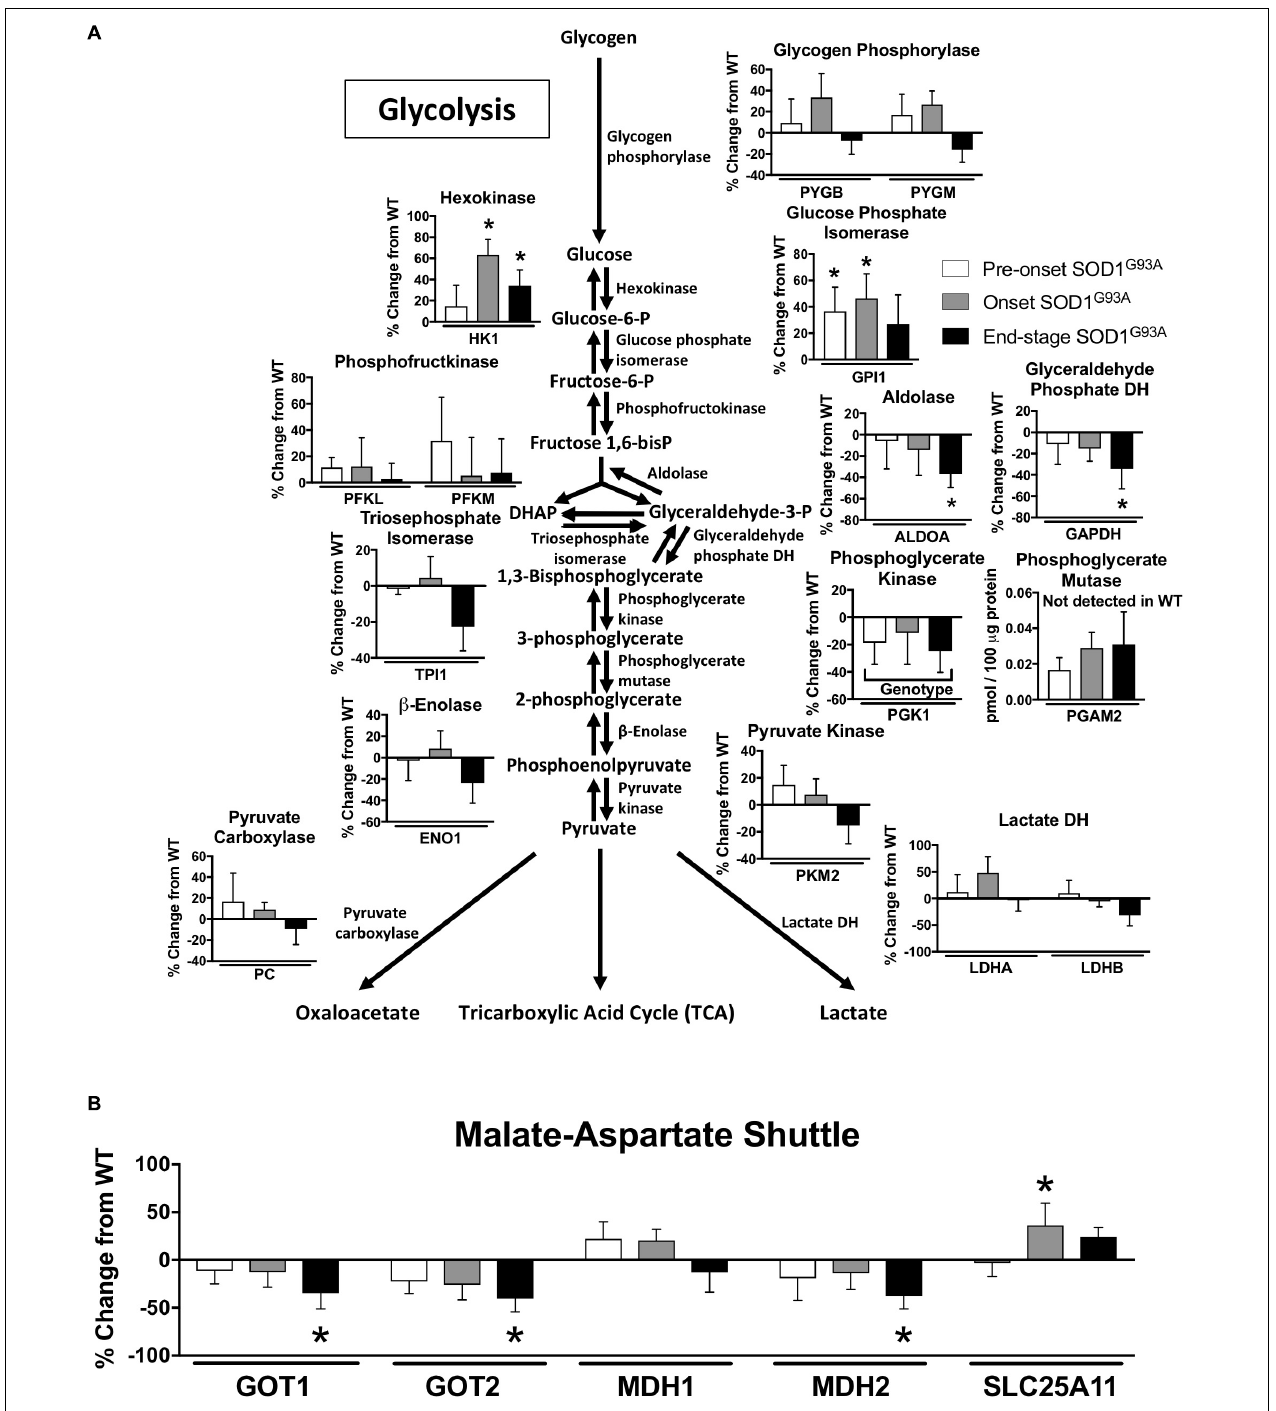
FIGURE 2 | Glycolysis and the malate-aspartate shuttle. Changes in protein content of carbohydrate metabolism in SOD1 G93A spinal cords compared to controls measured by mass spectrometry ( n = 5–6). (A) Glycolysis. (B) Malate-aspartate shuttle. Data are represented as percent change relative to the same time point wild-type control. Bars represent means ± standard deviation. Phosphoglycerate mutase 2 (PGAM2) did not reach the level of detection in wild-type samples but did in SOD1 G93A . “Genotype” denotes a significant genotype effect in Benjamini-Hochberg corrected two-way ANOVA with p < 0.05 but no individual Multiple Comparison test was significant. Significance symbols demonstrate p < 0.05 for a genotype effect and additional significant results for the Tukey Multiple Comparison test. ∗ p < 0.05 wild-type vs. SOD1 G93A at the designated time point. SOD1 G93A pre-onset (white), SOD1 G93A onset (gray), SOD1 G93A end-stage (black). DH, dehydrogenase; DHAP, Dihydroxyacetone phosphate. Protein names, IDs, and absolute expression values are detailed in Supplemental Table 1 .